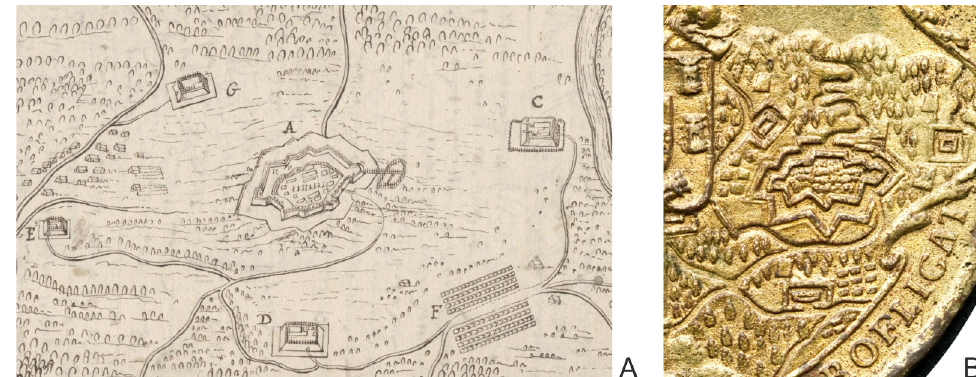
Fig. 6. The juxtaposition of the siege of the Arraial Velho do Bom Jesus fortress on the